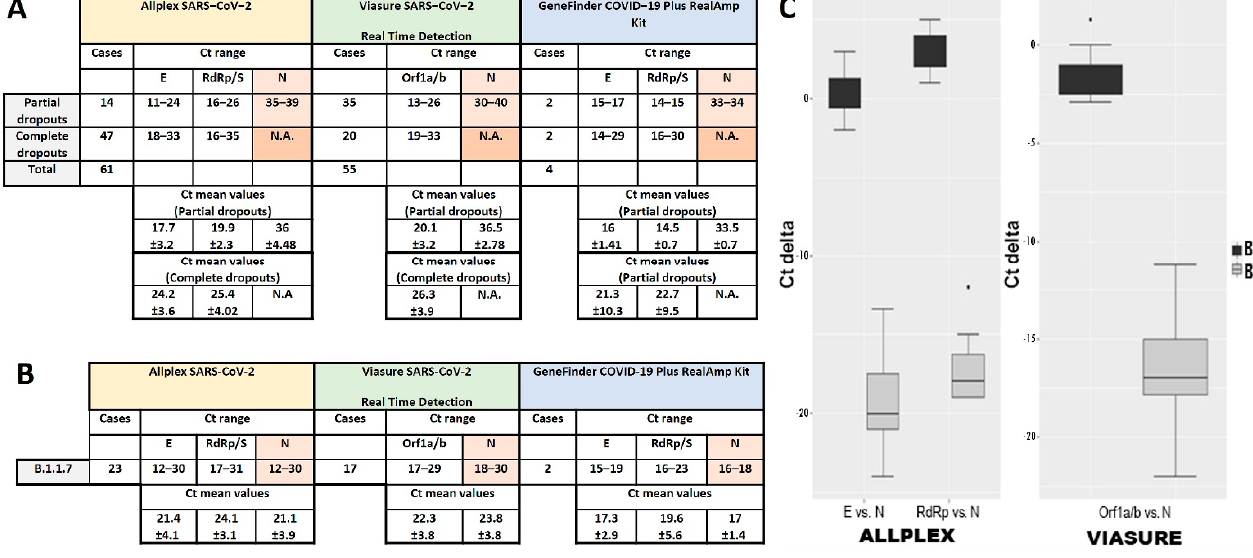
Figure 1. (A ) All three commercial detection kits show N amplification delay (partial dropout) or failure (complete dropout) in samples infected by the B.1.1.318 strain. (B ) 42 samples infected by the B.1.1.7 strain were tested with all three detection kits for comparison. RT-qPCR data as Ct range and Ct mean values for each target of each molecular assay are depicted. (C) Distribution of delta Ct values for cases without dropout infected with B.1.1.7 (black box plots) and with partial dropout infected with B.1.1.318 variant (grey box plots). The visualization of differences in the Ct values of N vs. E or RdRp/S genes in Allplex SARS-CoV-2 assay is presented in left graph and between N vs. Orf1a/b in Viasure SARS-CoV-2 Real Time Detection in right graph both for the groups of the B.1.1.7 and B.1.1.318 variants. The horizontal lines represent mean values of differences of Ct values.